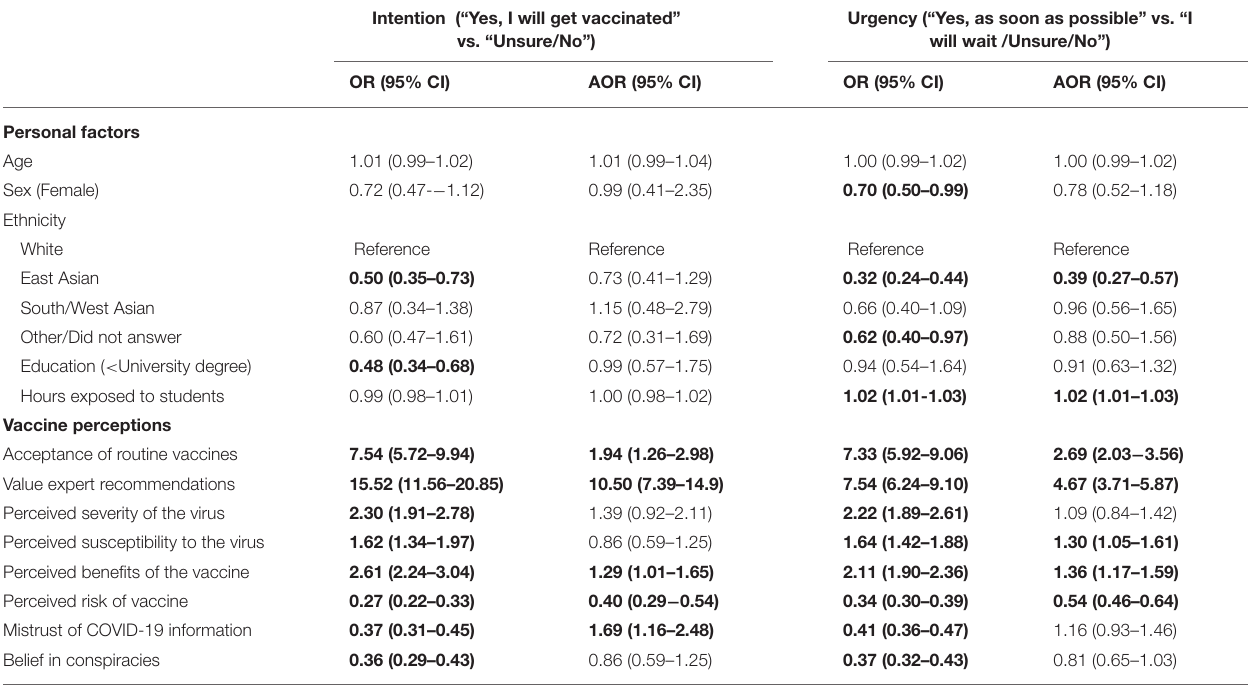
TABLE 3 | Univariable and multiple logistic regression models examining associations between personal factors, vaccine perceptions and COVID-19 vaccine intentions. Intention (“Yes, I will get vaccinated” Urgency (“Yes, as soon as possible” vs. “I vs. “Unsure/No”) will wait